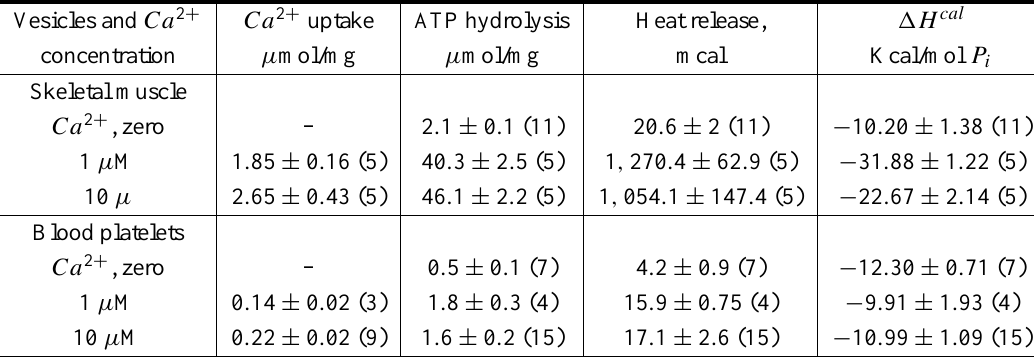
Energy interconversion by the Ca 2 + -ATPase of rabbit sarcoplasmic reticulum and human blood platelets endoplasmic reticulum.